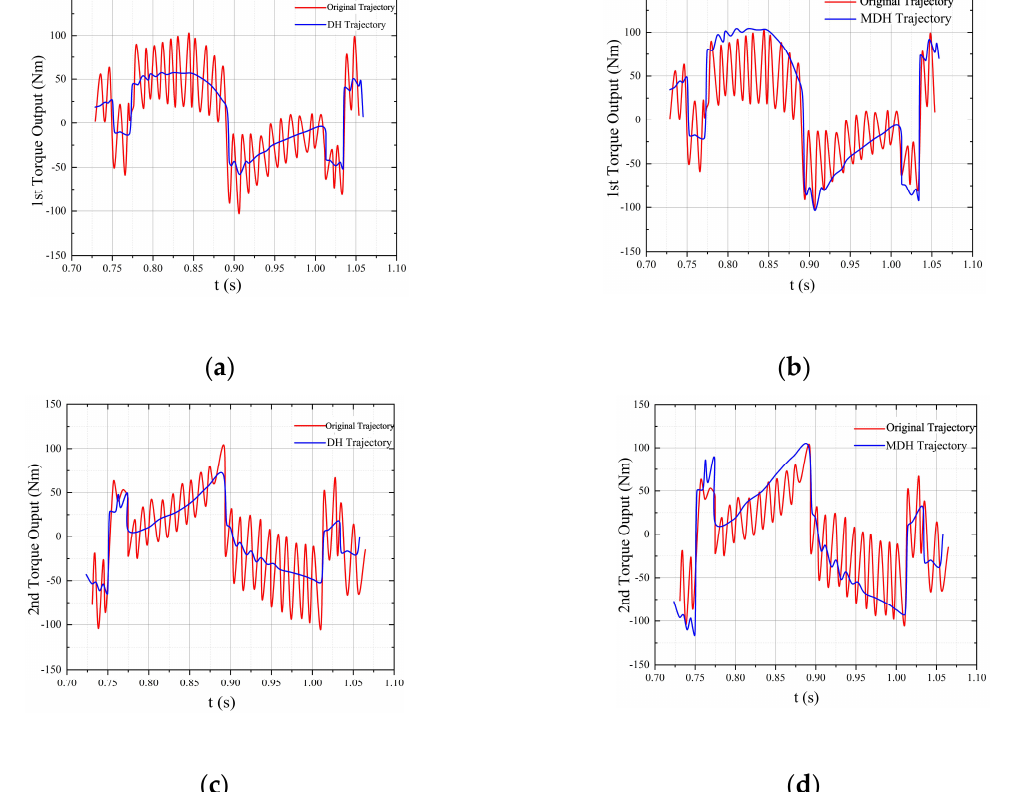
Figure 12. Control behaviours of the DH and MDH control algorithms. ( a , b ) torque of the left link;